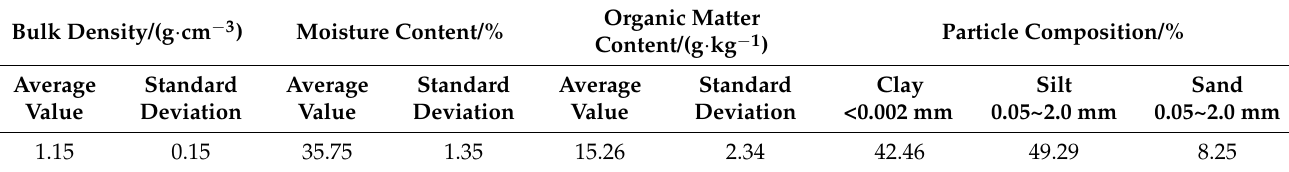
Table 1. The basic physical properties of the soil.